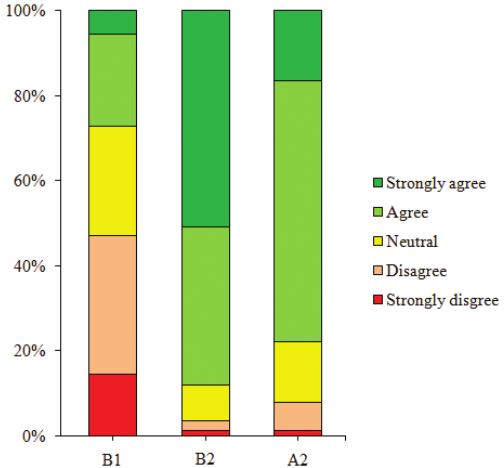
Figure A4. Cumulative responses to B1: Nuclear power plant is en -